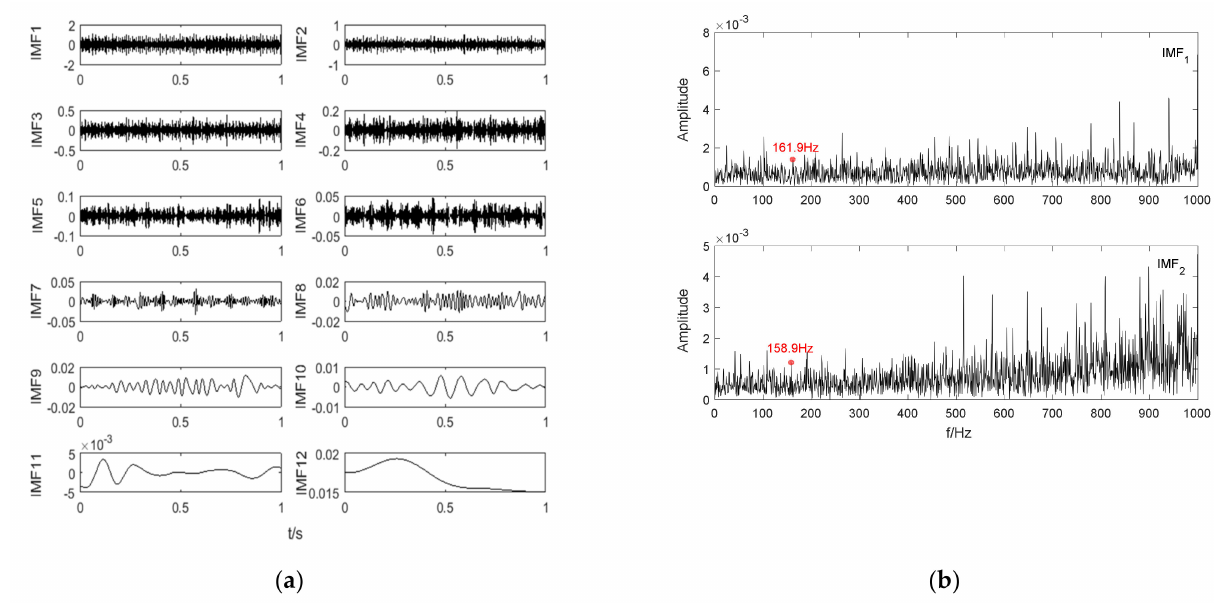
Figure 14. The decomposition results of EMD: ( a ) Time domain; ( b ) Frequency domain.